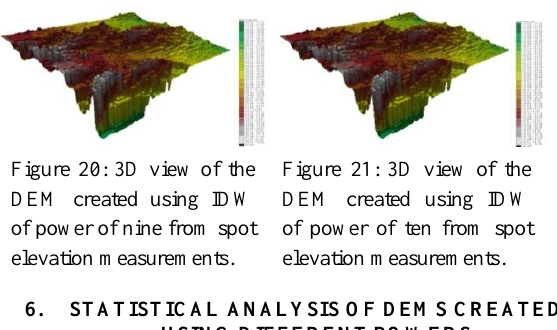
Figure 18: 3D view of the DEM created using IDW of power of seven from spot elevation measurements.